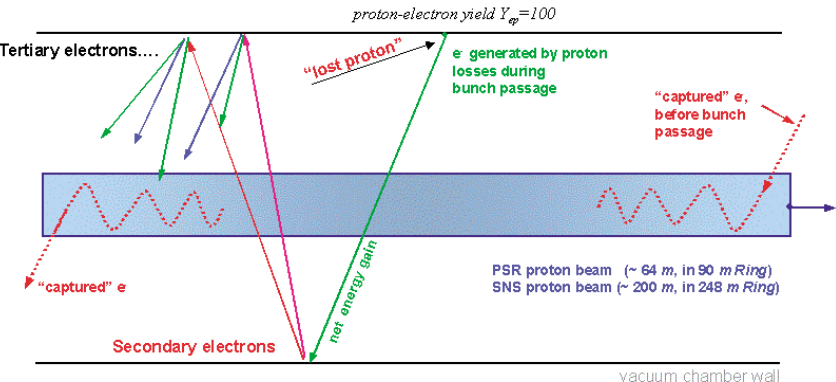
FIG. 5. (Color) Electron multiplication mechanism in long proton bunches.